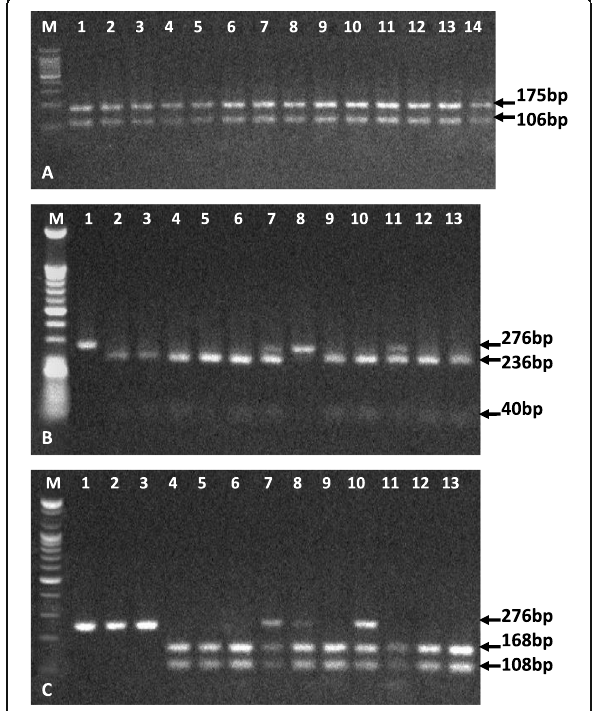
Fig. 1 Agarose gel electrophoresis of HLA-G gene PCR products in 3% agarose at 5 V/cm 2 . a PCR products digested with Hinf-I showing two bands (106 and 175 bp); Lanes 1 – 14: absence of HLA-G*01:03 allele. b PCR products digested with BseR-I showing three bands (40, 236, and 276 bp bands); lanes 1 and 8: homozygous HLA- G*01:04 allele; lanes 7 and 11: heterozygous HLA-G*01:04 allele; lanes 2 – 6, 9 – 10, and 12 – 13: absence of HLA-G*01:04 allele. c PCR products digested with PpuM-I showing three bands (108, 168, and 276 bp bands); lanes 1-3: homozygous HLA-G*01:05N allele; lanes 7 – 8 and 10: Heterozygous HLA-G*01:05N allele; lanes 4 – 6, 9, and 11 – 13: absence of HLA-G*01:05N allele. Lane M: 100 bp DNA ladder. The bands were visualized using UV trans-illuminator after staining